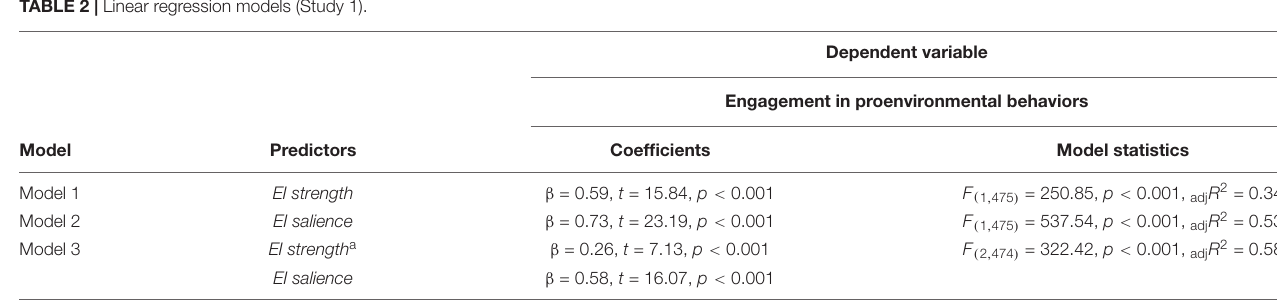
TABLE 2 | Linear regression models (Study